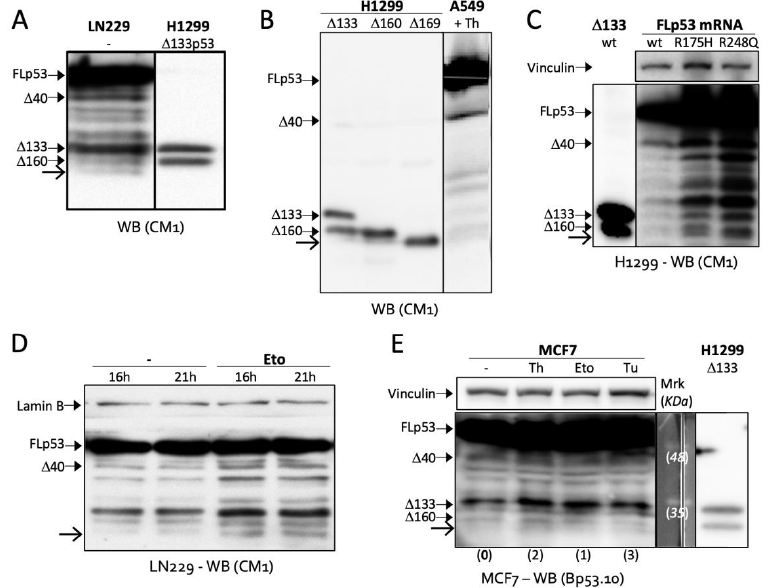
Figure 2. Stress-responsive band (indicated with open arrow) is observed under Δ160p53 band in Western blot analyses (WB) of LN229 ( A , D ), A549 ( B ) and MCF7 ( E ) cells endogenously expressing p53 and H1299 ( C ) cells expressing the indicated exogenous constructs. A549 ( B ), LN229 ( D ) and MCF7 ( E ) cells were treated with thapsigargin (Th, 16 h), etoposide (Eto), tunicamycin (Tu, 16 h) or DMSO ( − , 16 h) as indicated. Shown are representative data of at least three independent experiments and between brackets ( E ) relative quantifications of the band indicated with the open arrow. CM1, polyclonal anti-p53 antibody; Bp53.10, monoclonal antibody against the C-terminus (aa 374–378) of